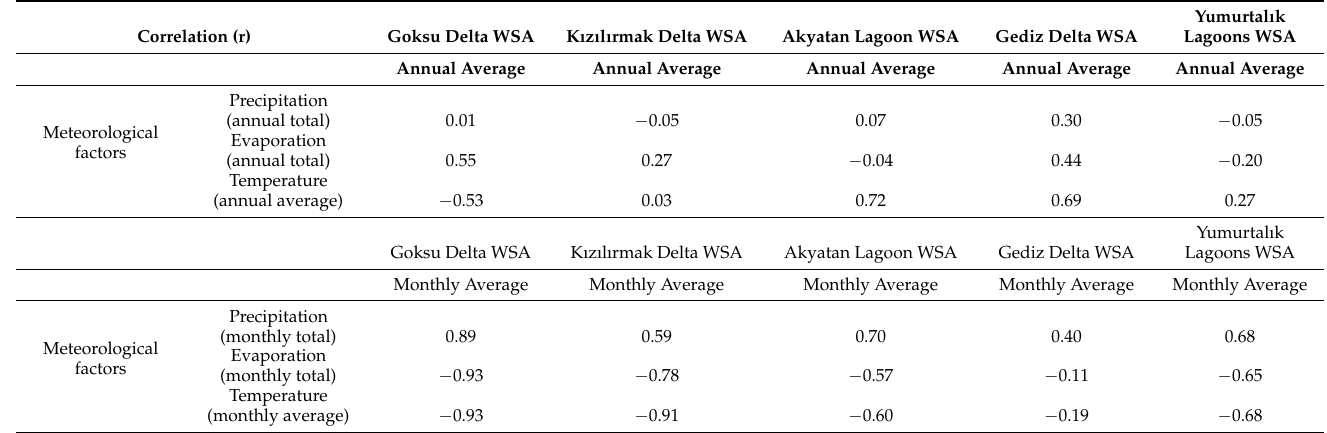
Table 4. Correlations with water surface areas (WSA) and meteorological factors.